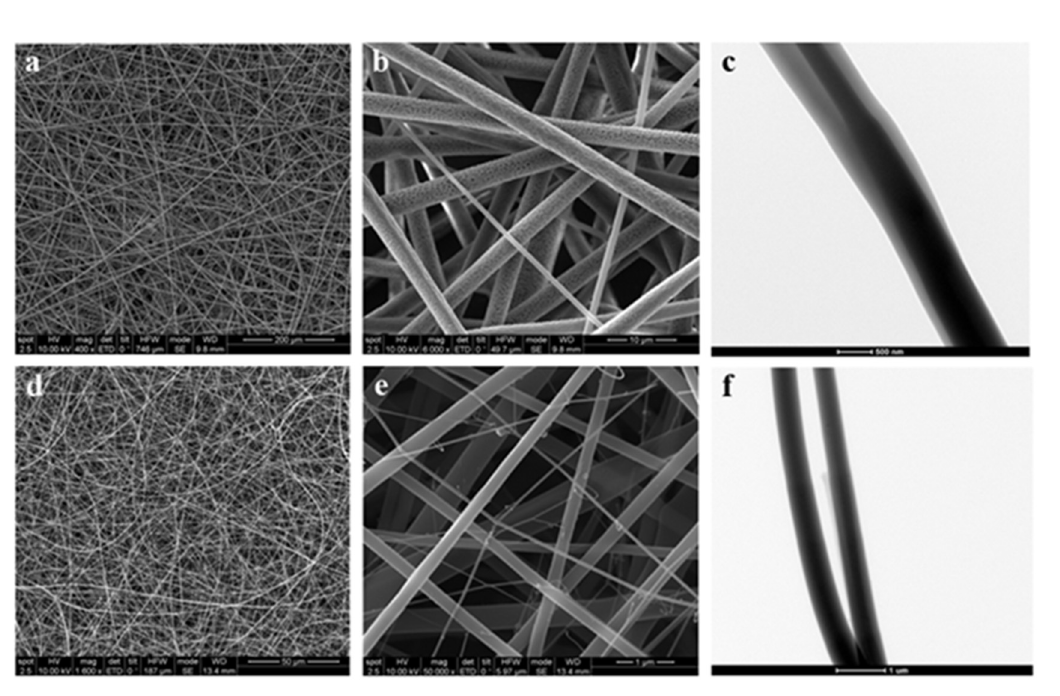
Figure 4. Scanning Electron Microscopy (SEM; a , b , d , e ) and Transmission Electron Microscopy (TEM; c , f ) micrographs of nanofibrous scaffolds, consisting of polylactic acid (PLLA)/polycaprolactone (PCL) ( a , b ) and chitosan ( d , e ) polymers, synthetized by electrospinning technique ( unpublished